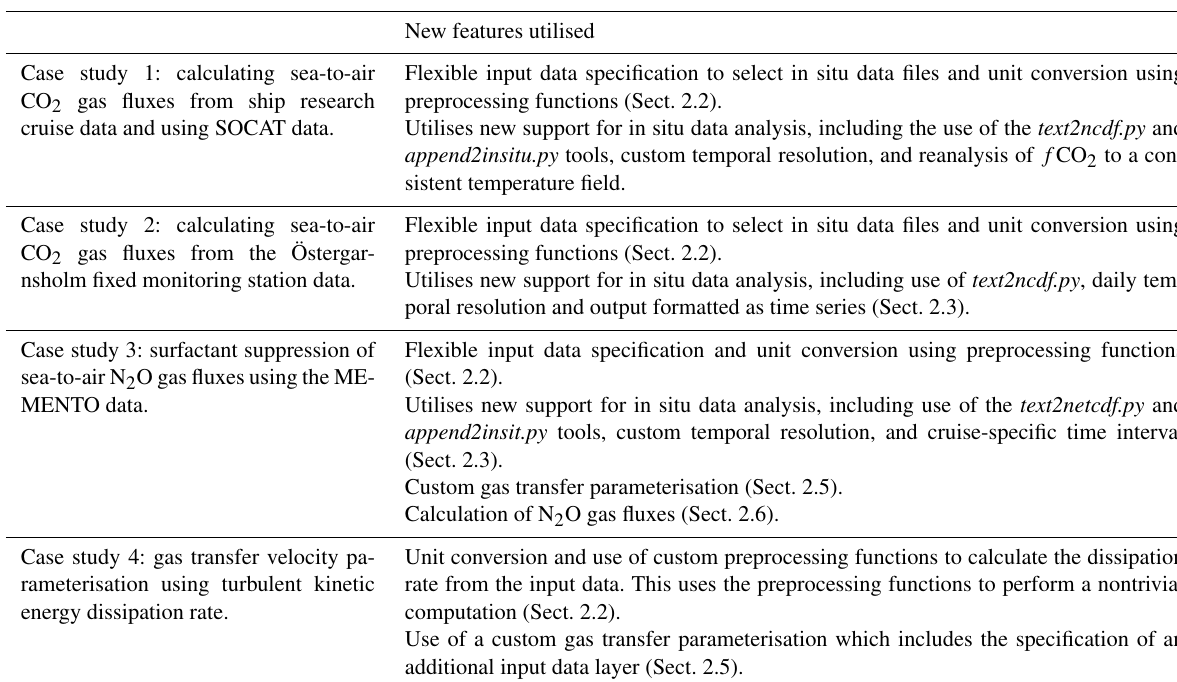
Table 1. Summary of the new functionality demonstrated in each case